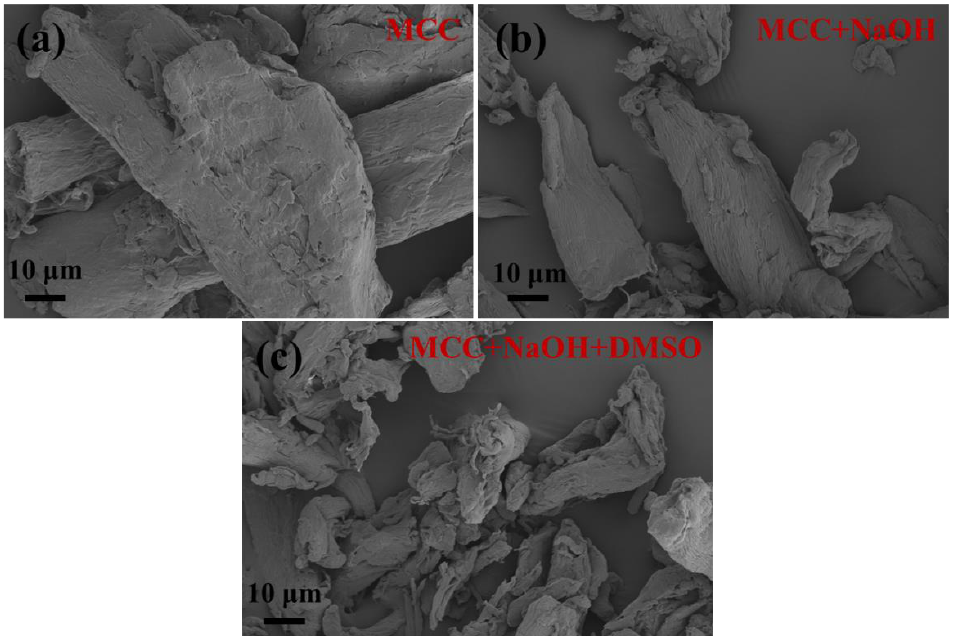
Figure 3. FE-SEM images of ( a ) MCC, ( b ) MCC after alkaline treatment, and ( c ) MCC after alkaline treatment and swelling treatment (1000 × magnification).